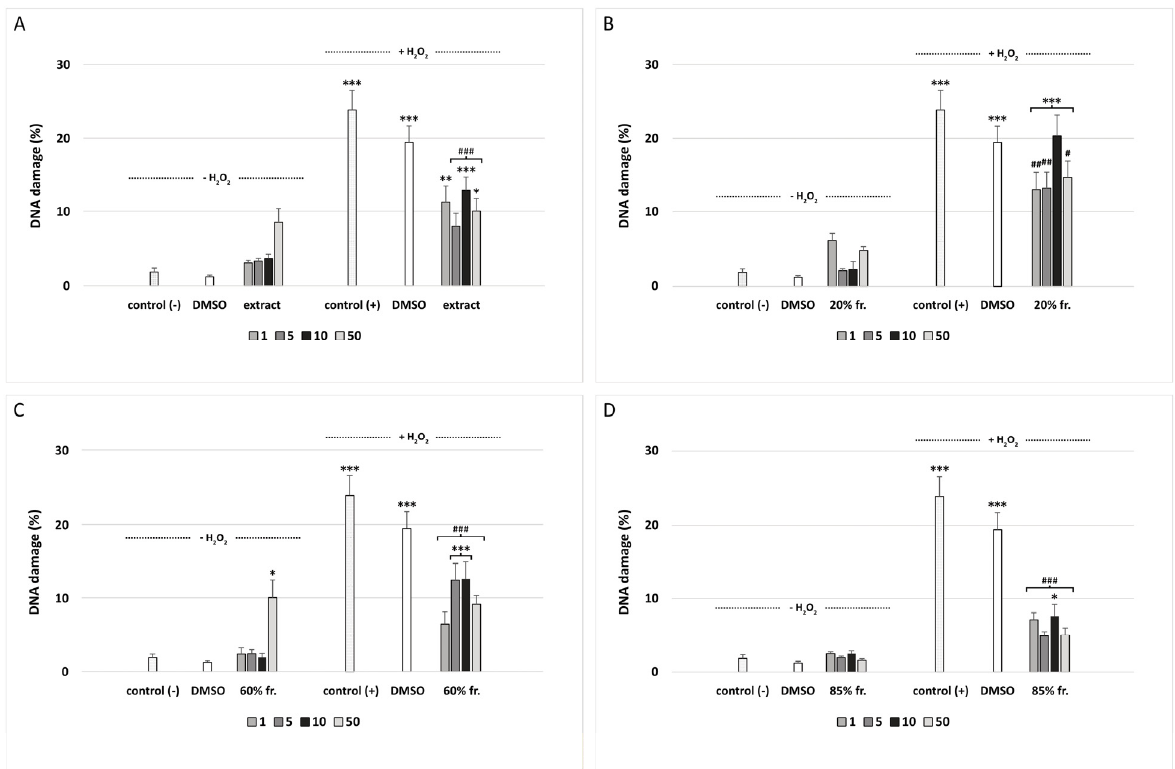
Figure 3. The effect of extract ( A ) and three fractions (20%, 60% and 85%; concentration range 1–50 µg/mL; pre-incubation time: 2 h) ( B – D , respectively) on DNA damage in PBM cells treated with H 2 O 2 at 25 µM for 15 min on ice. Data represent means ± SEM of 3 experiments (from different donors). * p < 0.05, ** p < 0.01, *** p < 0.001 (compared with control ( − )); # p < 0.05, ## p < 0.01, ### p < 0.001 (compared with control (+)).